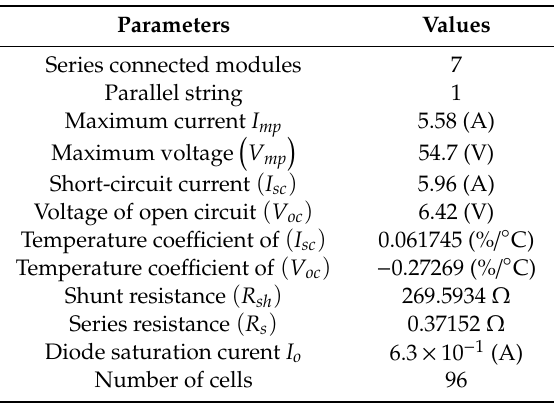
Table 1. Photovoltaic